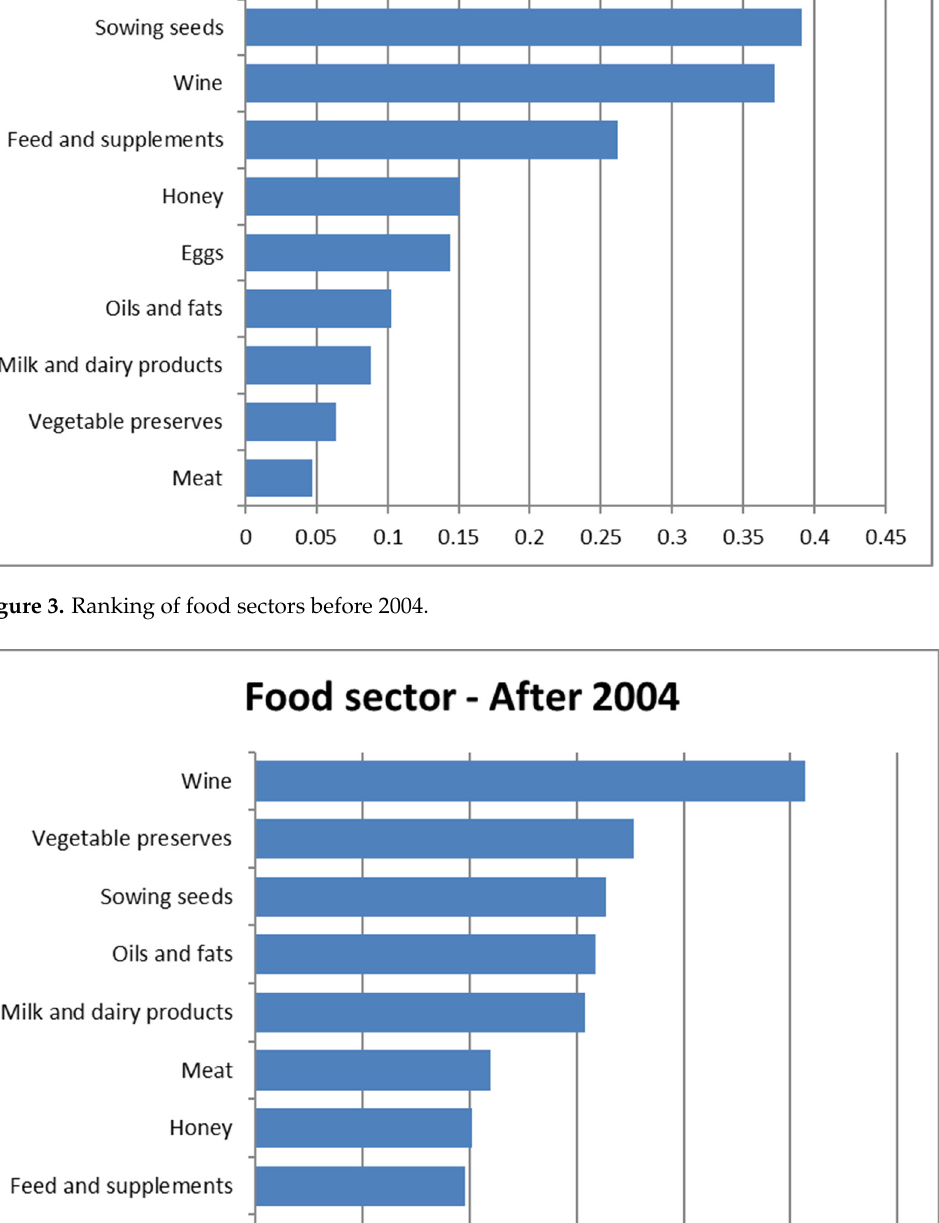
Table 6. Trend indices of the fraud rates in the food sectors for the period 1997–2020.